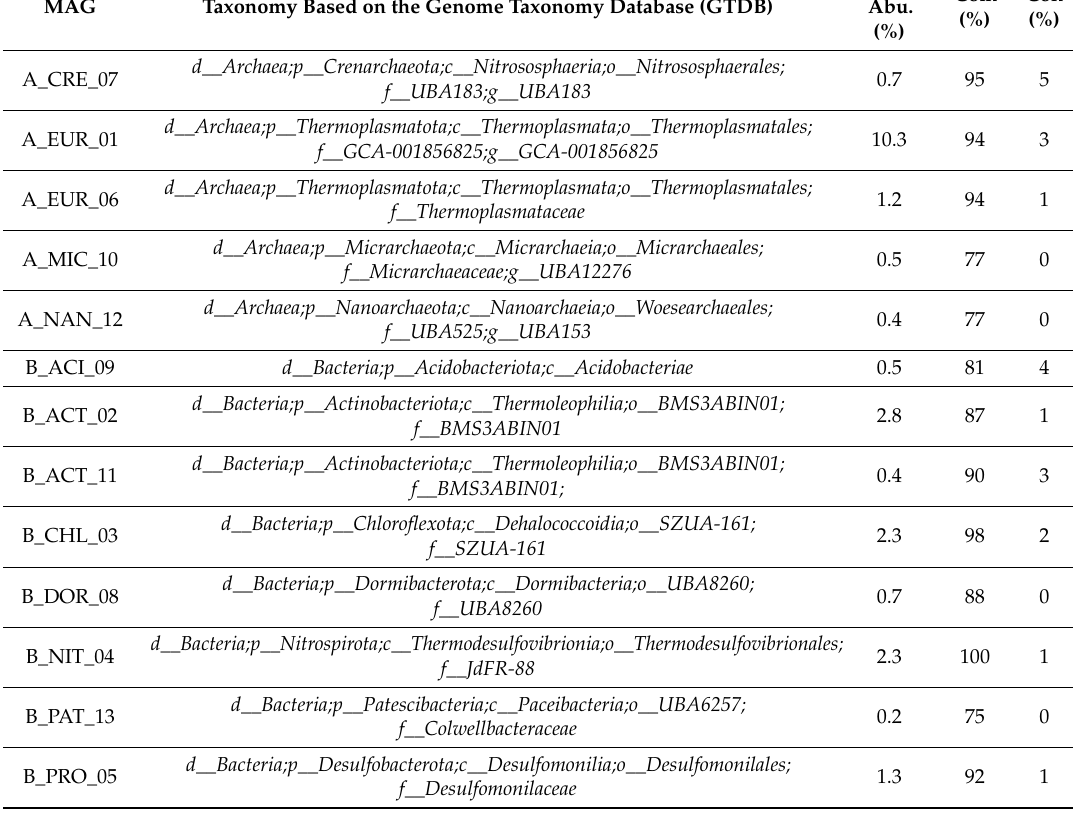
Table 5. Metagenome-assembled genomes (MAGs) obtained from the deep layer (35-m) of Cueva de la Mora (CM) representing di ff erent phyla (see Figure 1). MAG labels are constructed to indicate Domain_Phylum_Abundance Rank. Relative abundances (Rel. Abu.) were calculated based on total DNA-reads mapped to each MAG. Completeness (Com) and Contamination (Con)